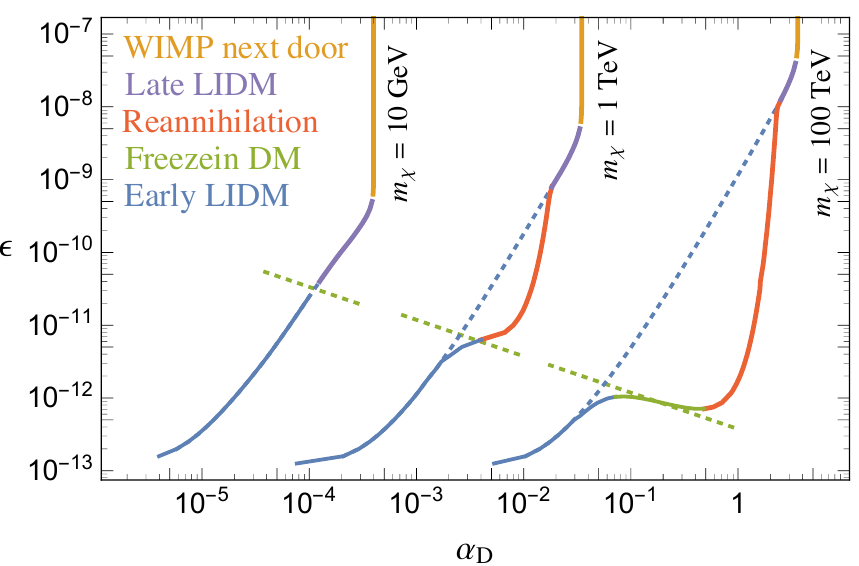
Figure 6. The breakdown of correct relic abundance solutions in the ( (cid:11) D ; (cid:15) ) parameter space for three di(cid:11)erent dark matter masses (1 GeV, 100 GeV, 10 TeV). Hidden sector freezeout while in thermal equilibrium with the SM (WIMP next door) is shown in orange. Late LIDM is shown in purple. Reannihilation is shown in red. Freezein is shown in solid green. Early LIDM is shown in solid blue. The \LIDM-only" solution, obtained by neglecting the freezein population from f (cid:22) f ! (cid:31) (cid:22) (cid:31) processes, is shown with the dashed blue line. The \freezein-only" solution obtained by considering only the f (cid:22) f ! (cid:31) (cid:22) (cid:31) and neglecting (cid:31) (cid:22) (cid:31) ! Z D Z D and SM + SM ! Z D + SM processes is shown in dashed green. Note that the dashed blue line connects the early and late LIDM